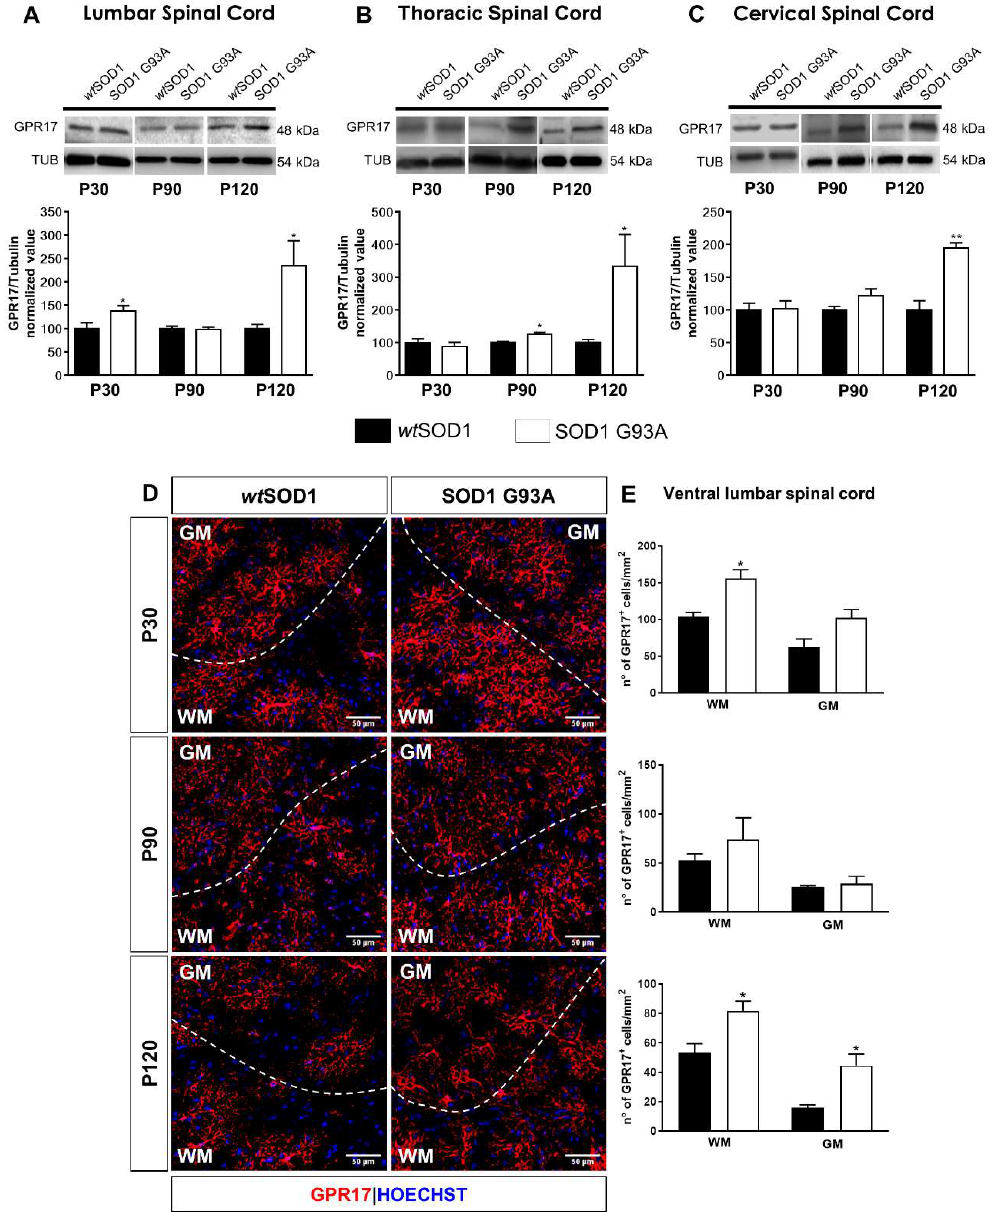
Figure 1. GPR17 expression is increased in spinal cord of SOD1 G93A mice. ( A – C ) Representative images and quantifications of GPR17 protein levels analyzed by western blot in lumbar ( A ), thoracic ( B ), and cervical ( C ) spinal cord of wt SOD1 and SOD1 G93A mice at P30, P90, and P120. Histograms show the results of densitometric analysis. Data are expressed as mean ± SE ( n = 6); * p < 0.05; ** p < 0.01 SOD1 G93A vs. wt SOD1, non-parametric Mann–Whitney test. ( D ) Representative images of GPR17 staining in the ventral lumbar spinal cord of wt SOD1 and SOD1 G93A mice at pre-symptomatic stage P30, early symptomatic stage P90 and late symptomatic stage P120. Dashed line separates white matter (WM) and grey matter (GM). Hoechst 33258 was used to label cell nuclei. Scale bar: 50 µm. ( E ) Histograms show the quantitative analysis of the density of GPR17 + cells in WM and in GM of the ventral spinal cord ( n = 3; 2/3 sections for animal). * p < 0.05 SOD1 G93A vs wt SOD1; Student’s t -test. In parallel, alterations of the oligodendrocyte di ff erentiation process were assessed by analyzing + the density of CC1-expressing (CC1 ) cells, representing cells that have completed their di ff erentiation process and reached a mature phenotype [36]. The number of mature oligodendrocytes was slightly